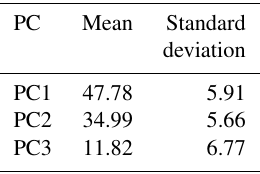
Table 3. Mean and standard deviation of variance explained (%) by each PC throughout the 25 bootstrapped